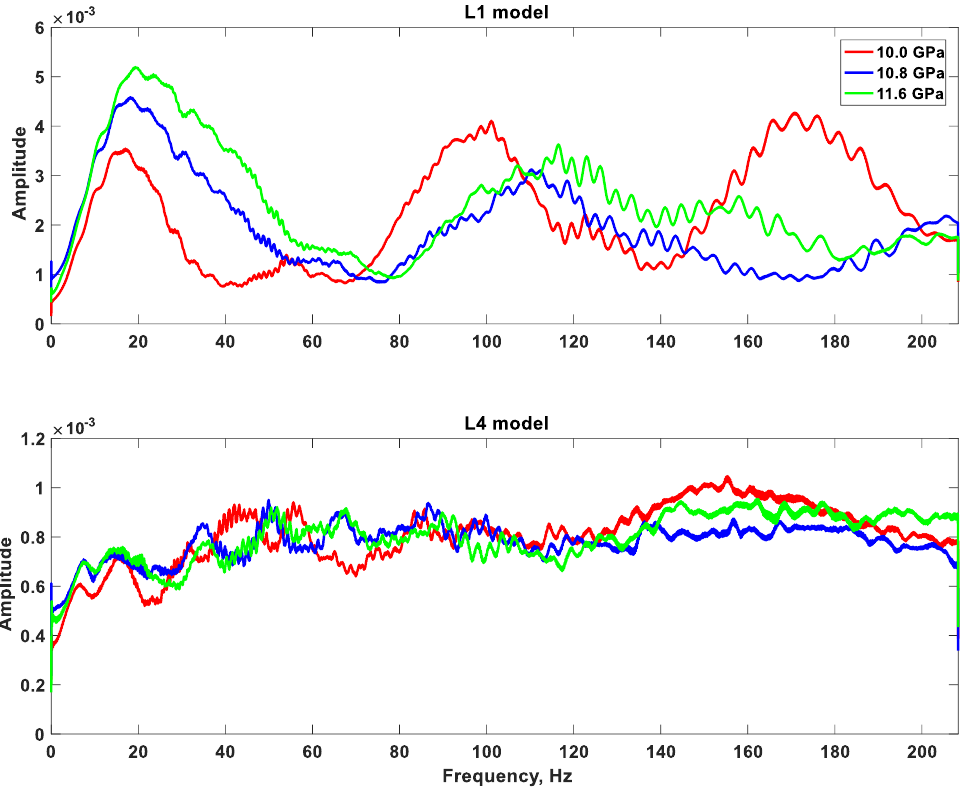
Figure 12—Comparison of the spectrums of the microseismicity induced in the models with different Young’s